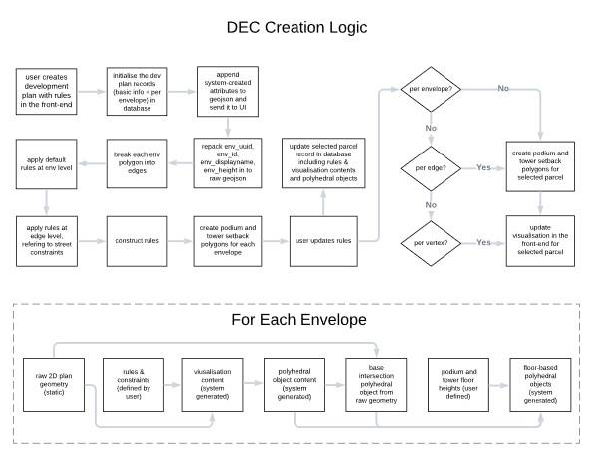
Figure 2. The overview workflow for Development